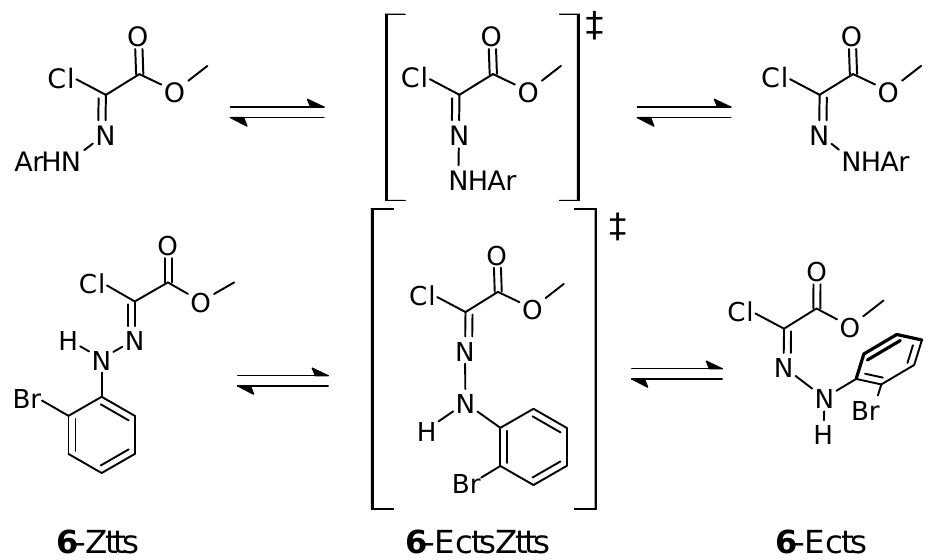
Figure 16. Schematic depiction of the umklapp mechanism for the ( E , Z ) interconversion in a generic C -methoxycarbonyl- N -aryl chlorohydrazone ( top ) and in the specific example 6 -Ztts/ 6 -Ects ( bottom ).